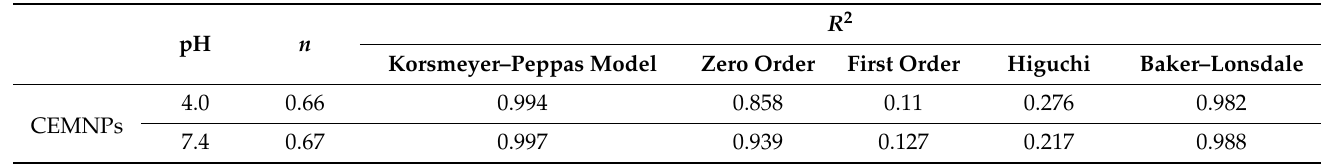
Table 1. Kinetic analysis of the in vitro release data of meloxicam from chitosan-encapsulated meloxicam nanoparticles.